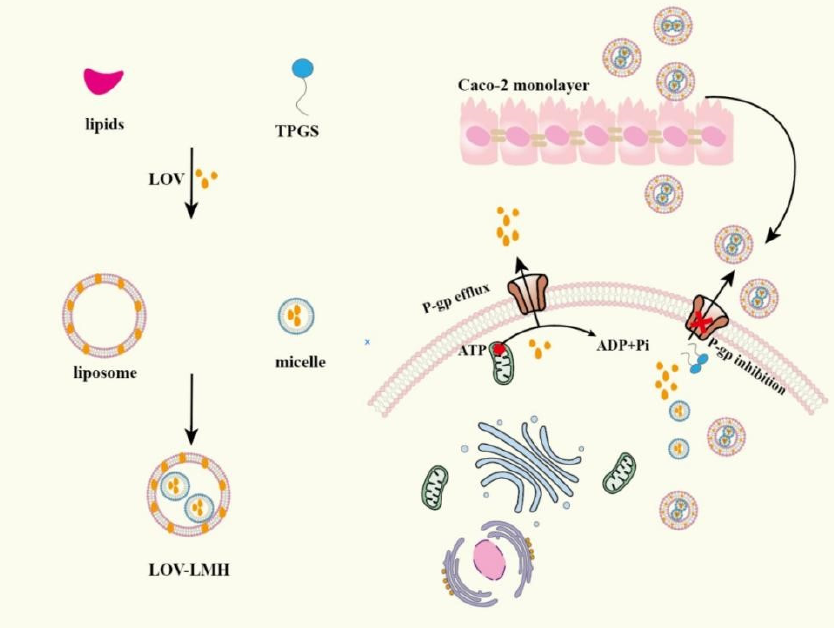
Figure 6. The mechanism of LOV-LMH improving the absorption of LOV in Caco-2 monolayer. Remodified and summarized with permission from [98]. Copyright© 2020 Elsevier B.V.